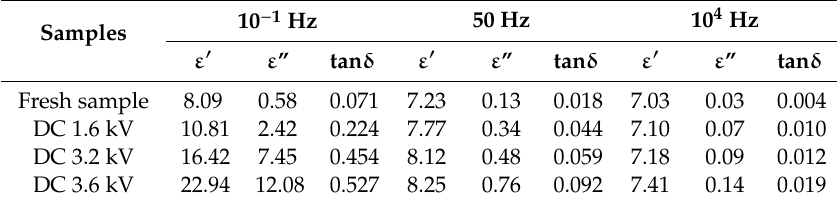
Figure 12. The dielectric parameters at different applied voltage ( γ 20 = 1000 μ S/cm, t = 8 h). ( a ) Real part, ( b ) imaginary part, ( c ) dielectric loss factor. Table 9. Variation of dielectric parameters at di ff erent applied voltage ( γ 20 = 1000 µ S / cm, t = 8